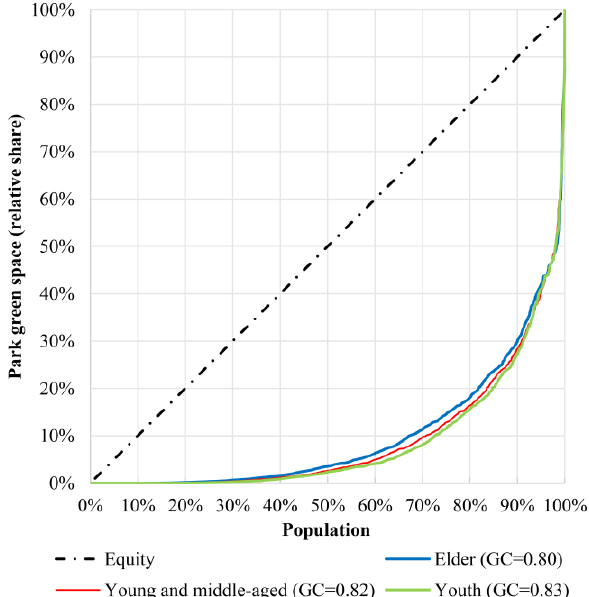
Figure 7. Lorenz curve and Gini coefficient of different age structure and park green space accessibility.